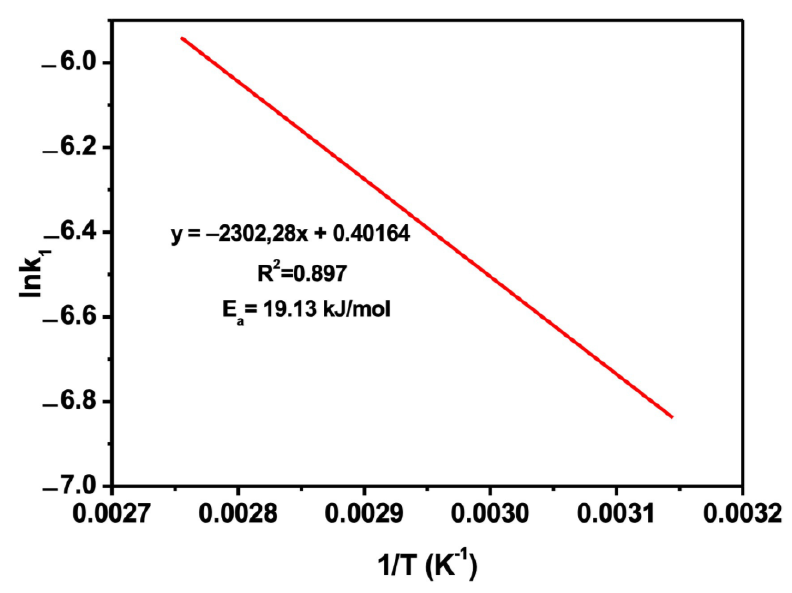
Figure 12. Plot of lnk 1 against 1/T for Fe leaching in additives conditions.